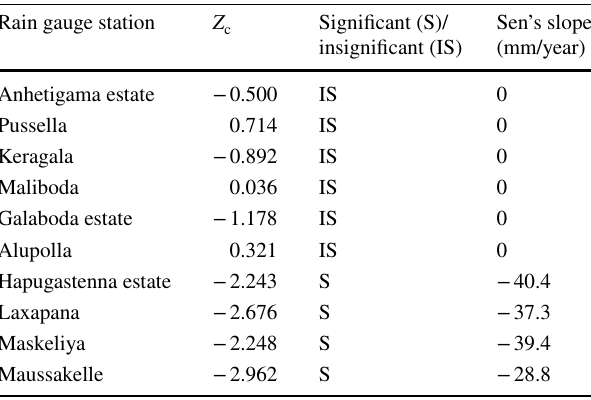
Table 1 Mann–Kendall test and Sen’s slope estimator test results for annual rainfall